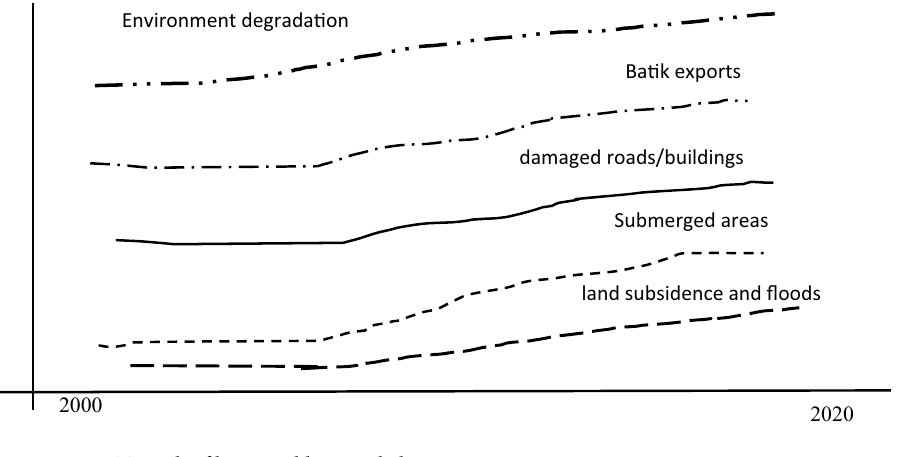
Figure 5. BOT graph of key variables in